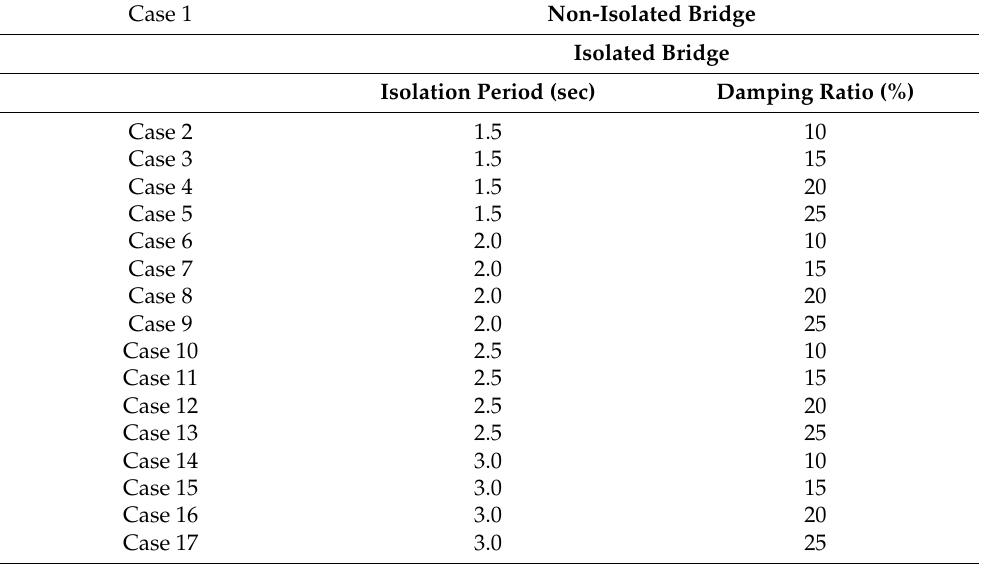
Table 3. Various cases considered for comparison of the response of bridge with respect to non- isolated